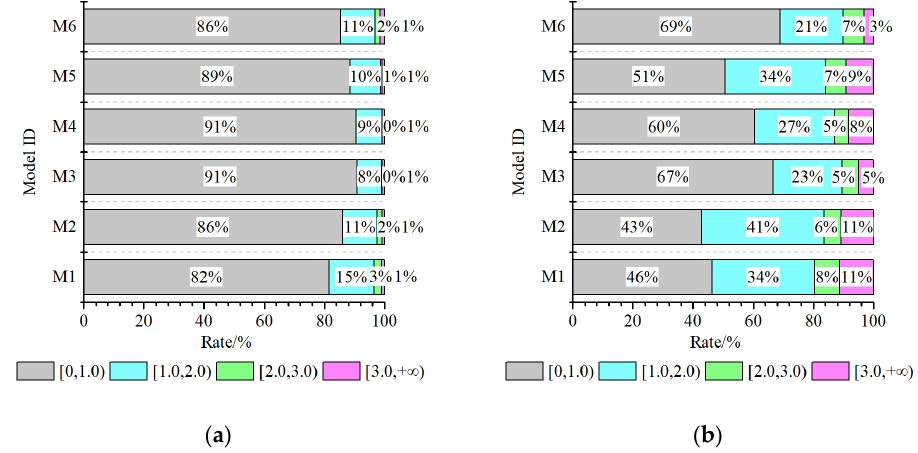
Figure 21. The average column hinge rate across the slope direction: ( a ) a PG, x = 0.4 g; ( b ) a PG, x = 0.62 g.